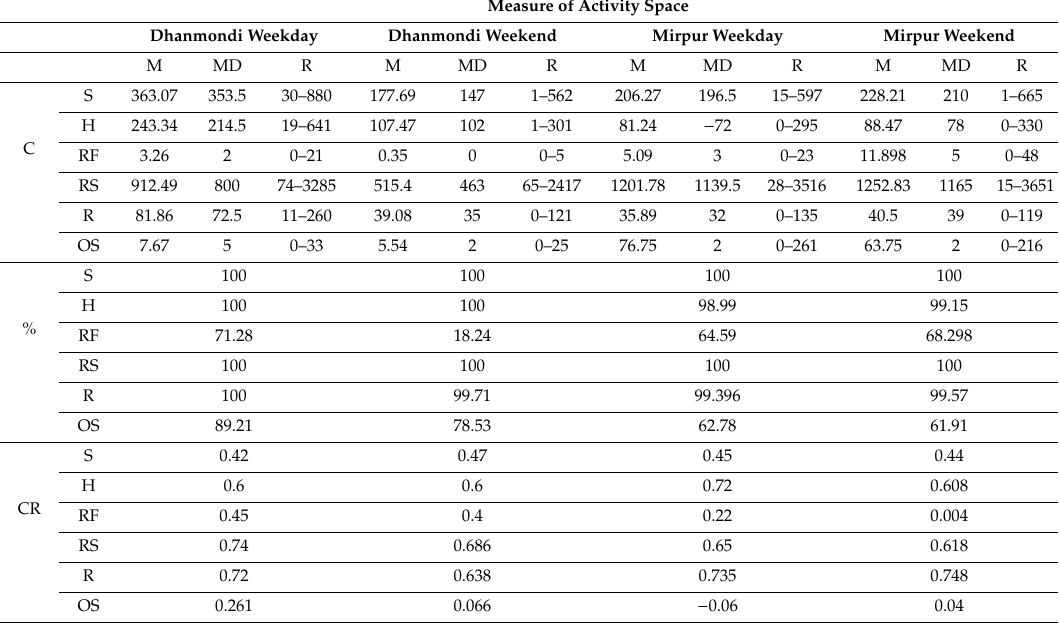
Table 17. Access to opportunities for road network bu ff er by Dhanmondi and Mirpur respondents for weekday and weekend